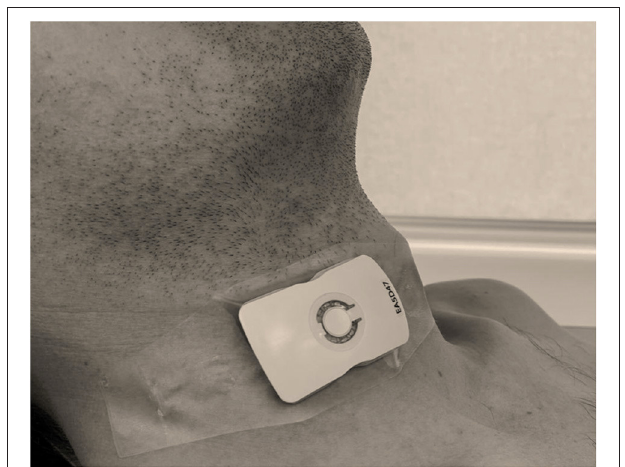
FIGURE 2 | Picture of wireless, wearable Doppler